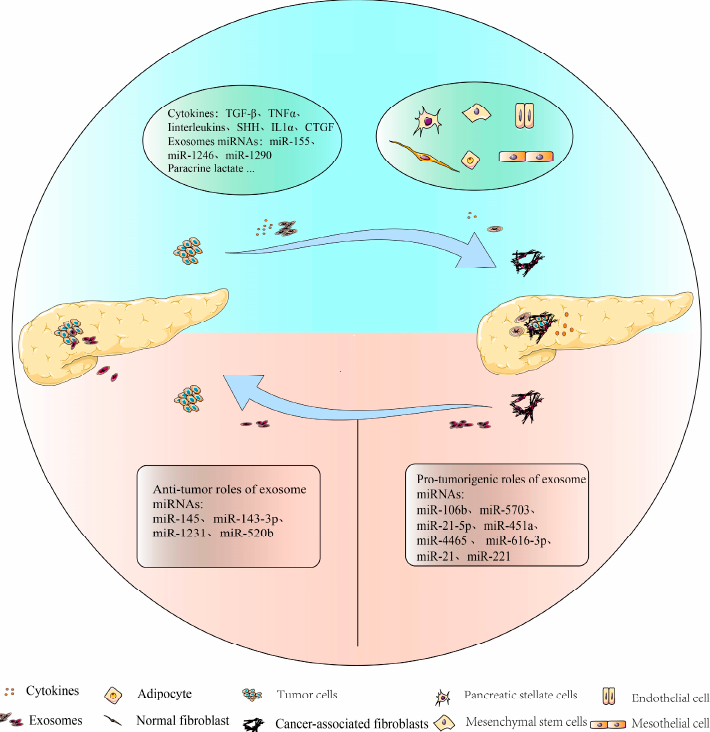
Figure 1. Exosomal miRNAs are involved in the crosstalk between PDAC cells and cancer-associated fibroblasts.